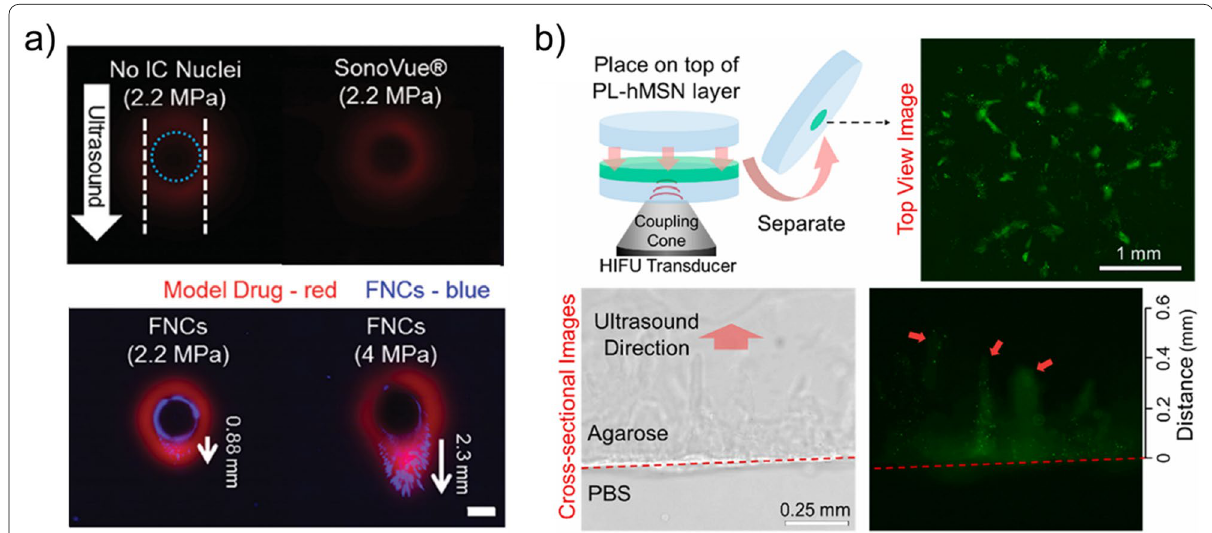
Fig. 11 a Representative fluorescence images showing nanocup penetration to a tissue model hydrogel after ultrasound treatment. Adapted from reference [37], Copyright 2015, John Wiley and Sons. b Phospholipid stabilized hydrophobic MSN penetration to agarose gel due to the generated cavitation events. Nanoparticles were labeled with fluorescein for imaging. Adapted from reference [46], Copyright 2018, American Chemical